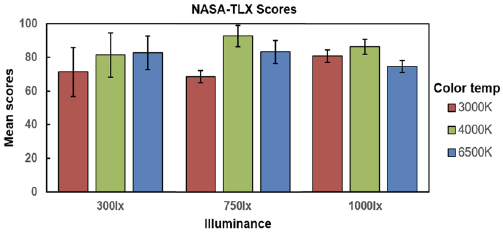
Figure 1. NASA-TLX scores (mean ± SD) under different conditions of colour temperatures (3000 K/4000 K/6500 K) and illuminance (300 lx/750 lx/1000 lx) levels. There was no significant main effect result for either the illuminance or the colour temperature. The interaction effect between illuminance and colour temperatures was also not significant.